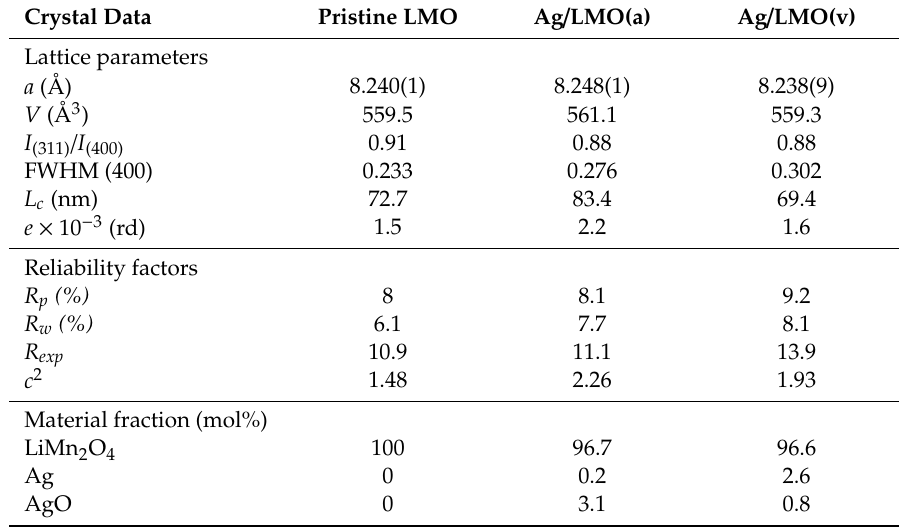
Figure 2. ( a ) XRD patterns of pristine, Ag / LMO(a) and Ag / LMO(v) samples recorded with CuK α XRD source. Inset shows the detailed (111) reflection. ( b ) Sketch of the crystal structure of LiMn 2 O 4 . Table 2. Results of Rietveld refinements for pristine and Ag-modified LiMn 2 O 4 . The phase fraction was refined with uncertainty of 0.1%.